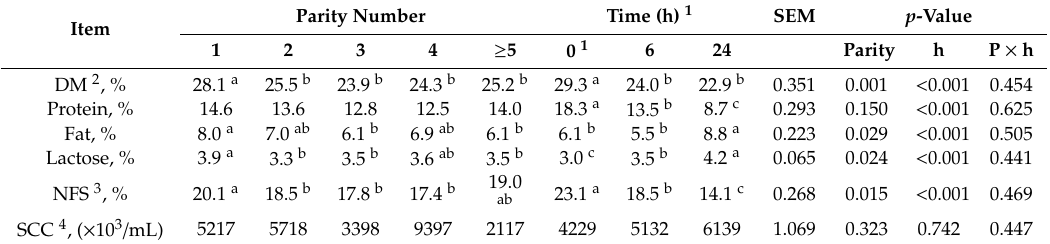
Table 2. E ff ect of parity number and sample collection time on the chemical compositions of colostrum from Large-White × Landrace